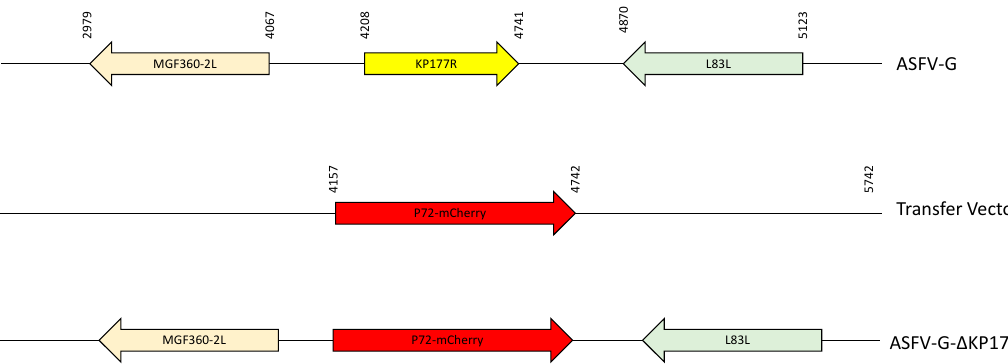
Figure 2. Schematic for the development of ASFV-G- ∆ KP177R. The transfer vector contains the p72 promoter and an mCherry cassette; the flanking left and right arms are indicated and were designed to have flanking ends to both sides of the deletion/insertion cassette. The nucleotide positions of the ASFV-G genome are indicated. The resulting ASFV-G- ∆ KP177R virus with the cassette inserted is shown at the bottom.